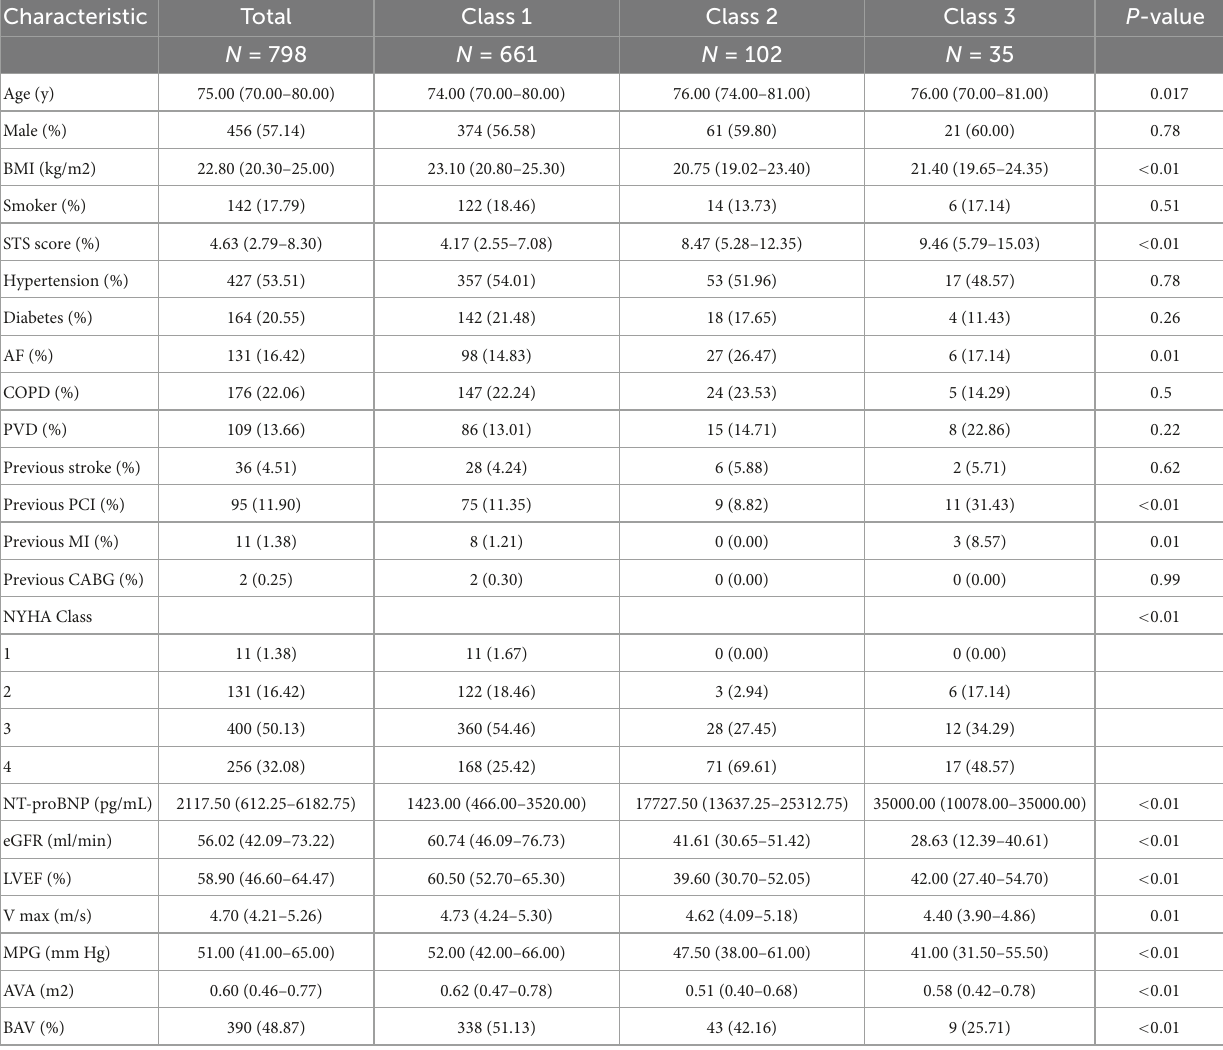
TABLE 1 Baseline characteristics stratified by different trajectories.